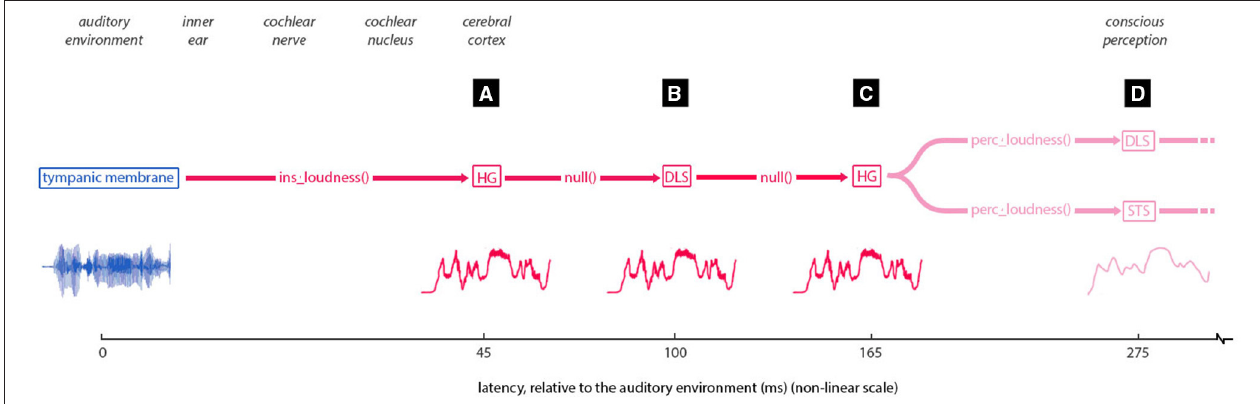
FIGURE 5 | Implied pathway of loudness information. Traces one interpretation of the pathway suggested by the findings of this study, with latencies (A–D) (labeled in black boxes), corresponding to those same labels in Figures 3A,B . First, the instantaneous loudness transform is applied, with the result of this transformation being entrained in Heschl’s gyrus [HG] at 45ms. This information is then moved or copied (seemingly untransformed) to the dorsal lateral sulcus (at 100-ms latency) and from there back to HG at 165ms (locations are approximate due to the source localization error). From here, the instantaneous loudness is transformed to the short-term loudness, to be entrained in both the dorsal lateral sulcus and superior temporal sulcus (at 275ms